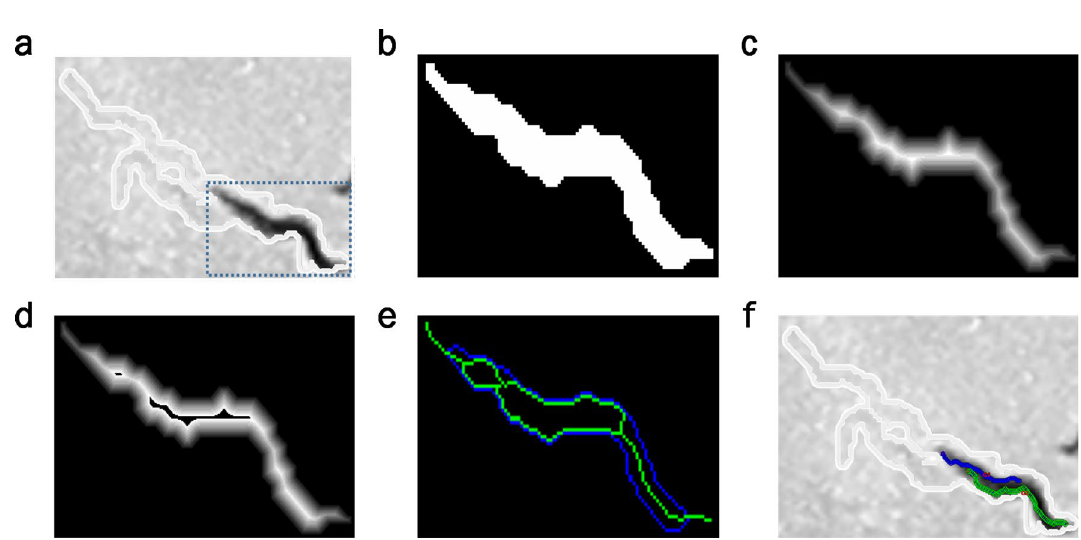
Figure 4. Example of tracks of two connected C. elegans . Proposed method steps. ( a ) Cropped subimage containing a current blob. ( b ) Segmentation of the current subimage. ( c ) Distance transform coded by grey intensity levels. ( d ) Background transform by using the maximum width value. ( e ) New skeletons. ( f ) Optimisation result (predicted